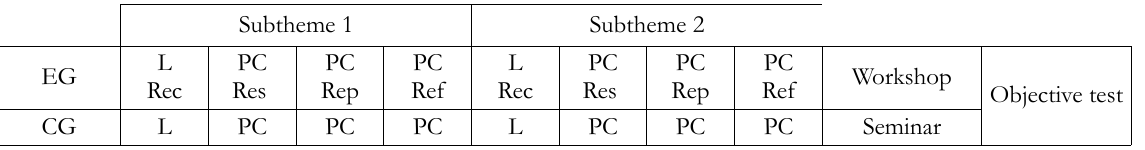
Table 4. Time distribution of the intervention in the experimental (EG) and control group